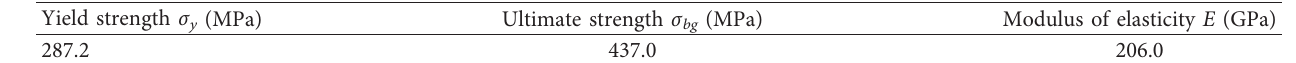
Table 4: Mechanical properties of steel bars.